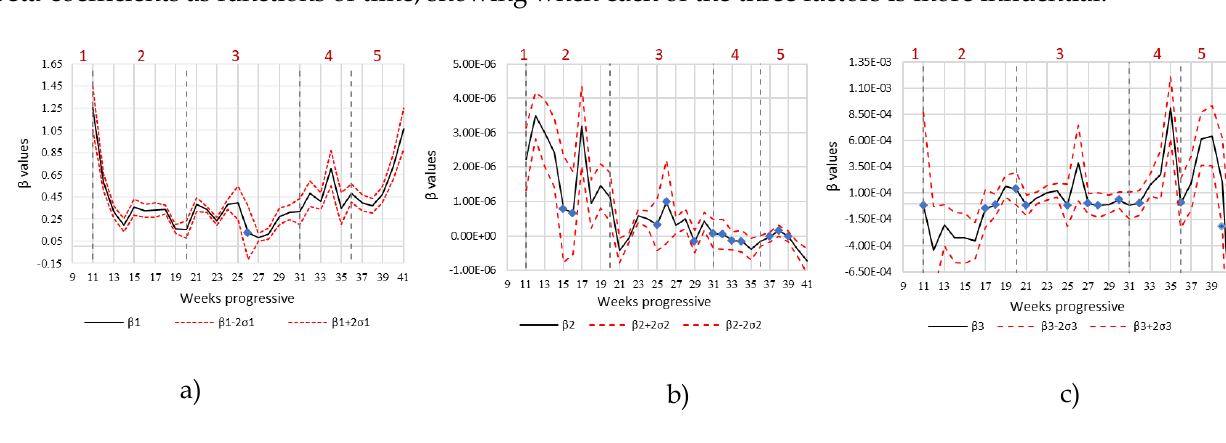
Figure 8. Beta-coefficients graphs of (Equation 11), lag 1 week: a) internal infections, b) external infections, c) stay-at-home effect. The dots mean that the coefficient for that week is not significant, as also understandable from the confidence intervals.